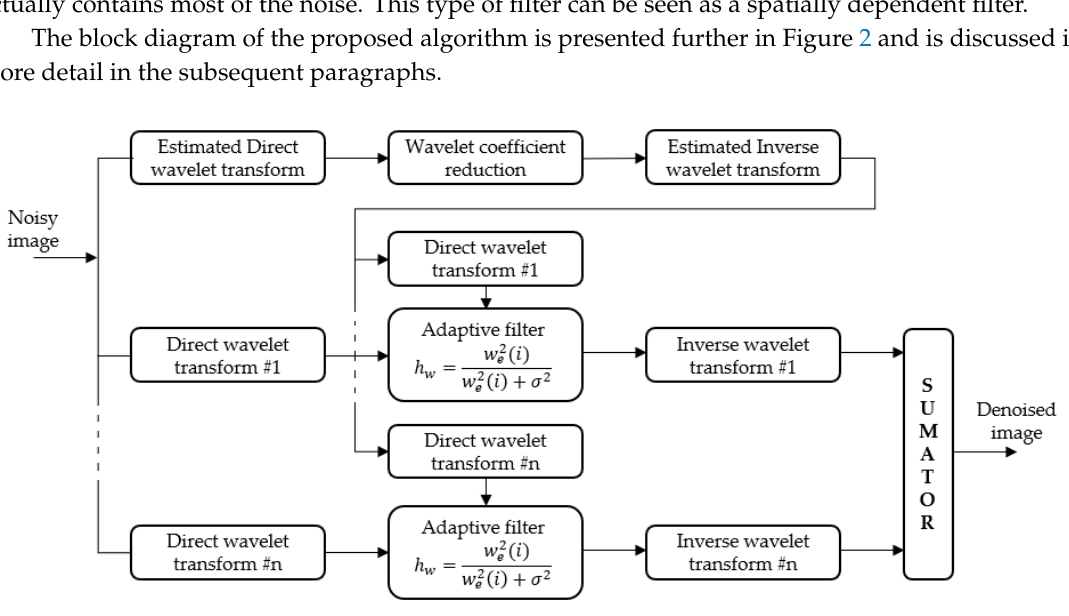
Figure 2. Block diagram of the proposed algorithm.